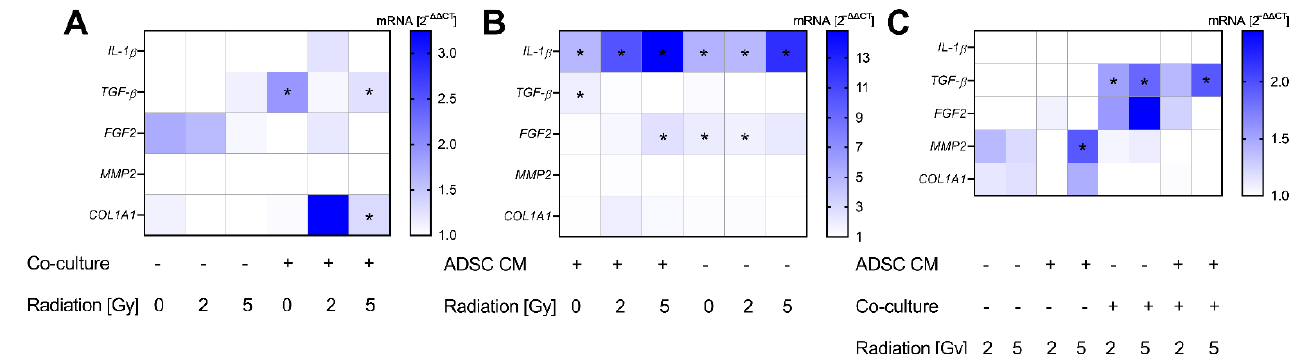
Figure 5. Alterations in gene expression profiles at the mRNA level in MRC-5 cells. The heatmaps show mean relative mRNA expression in MRC-5 cells compared to GAPDH/YWHAZ and to the corresponding control group, n = 3 replicate experiments. ( A ) Shows the effect of treatment with conditioned medium (CM) of adipose-derived stem cells (ADSC) normalized to treatment with control CM. ( B ) Presents the effect of co-cultivation with MCF-10A cells normalized to fibroblast monocultures. The effect of irradiation is demonstrated in ( C ), whereby irradiation with 2 Gy and 5 Gy is normalized to 0 Gy. Values were calculated using the 2 − ∆∆ CT method, 2 − ∆∆ CT of control = 1. White fields: 2 − ∆∆ CT < 1; * p < 0.05, increased compared to the corresponding control (Mann–Whitney U-test). IL-1 β : interleukin-1 β , TGF- β : transforming growth factor- β , FGF2 : fibroblast growth